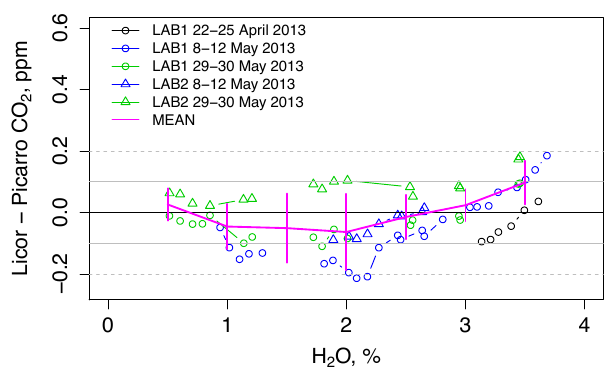
Fig. 9. Summary of recent dried Li-cor versus undried Picarro com- parisons using wetted ambient air that was passed through a mixing volume. Comparisons used two separate Picarro systems and two tall tower Li-7000 systems (LAB1 and LAB2). Mean results are shown in magenta, where the error bars represent one standard de- viation computed over two to four